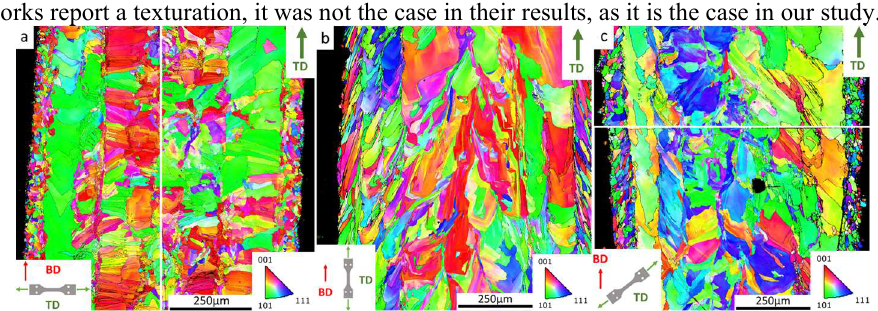
Fig. 4. EBSD images of Bd0_t1 (a), Bd90_t1 (b) and Bd45_t1 (c) along the Tensile Direction